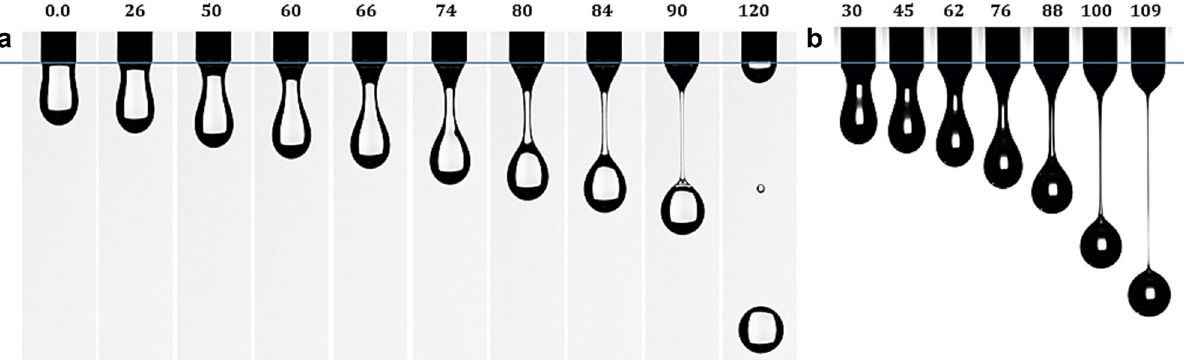
Figure 2. Dynamics of the droplet formation and the evolution of the neck filament of silicon oil in air at v 0 = 10 mm/s; ( a ) experiment E1 (2000 fps), ( b ) experiment E2 (4000 fps). The reference droplet configuration (